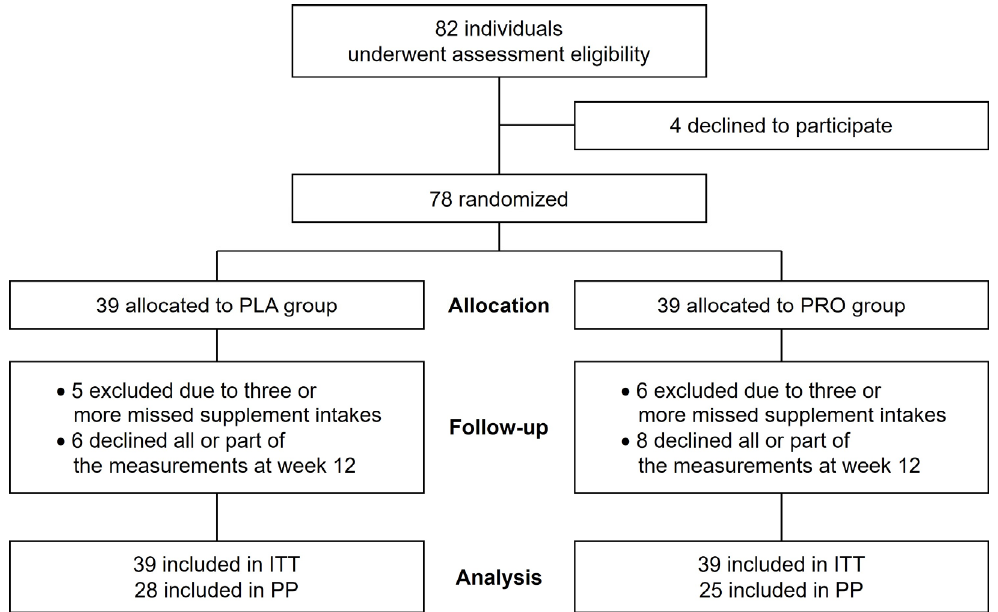
Figure 1. CONSORT flowchart. PLA, placebo; PRO, propolis; ITT, intention-to-treat; PP, per-protocol. Obtained from honeybee hives and extracted using ethanol. Wheat germ oil is extracted by pressing the wheat germ and is used as a solvent for propolis supplements. Therefore, it was selected as a placebo in this study. The supplements used in the present study are commercially available as health foods. As for the dosage of propolis, an animal toxicity study has shown that the non-observed effect level is 1400 mg/kg/day [20]. In reports on human subjects, 400–900 mg/day of propolis has been applied to patients with rheumatoid arthritis [21], type 2 diabetes mellitus [22], or COVID-19 [23], and elderly people (average 72.8 years) [24]. In the present study, 454 mg/day of propolis was administered to the subjects and none of them complained of side effects. This suggests that propolis and its dosage used in the present study are likely to be safe.